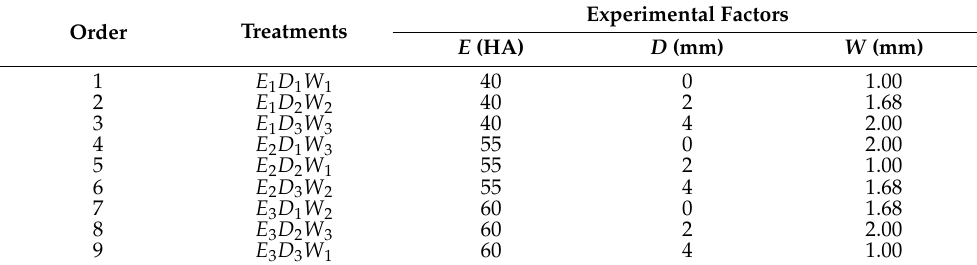
Table 1. Experimental